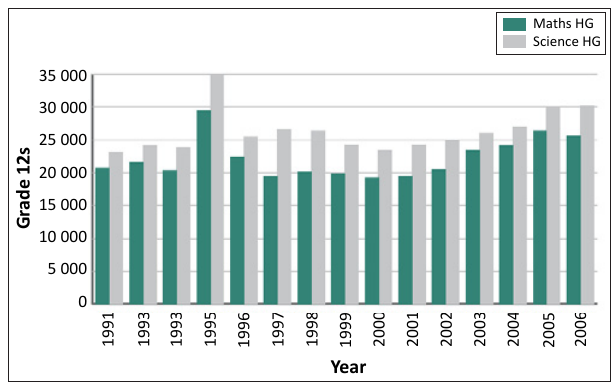
FIGURE 2: Decline in Grade 12 mathematics and science results between 1991 and